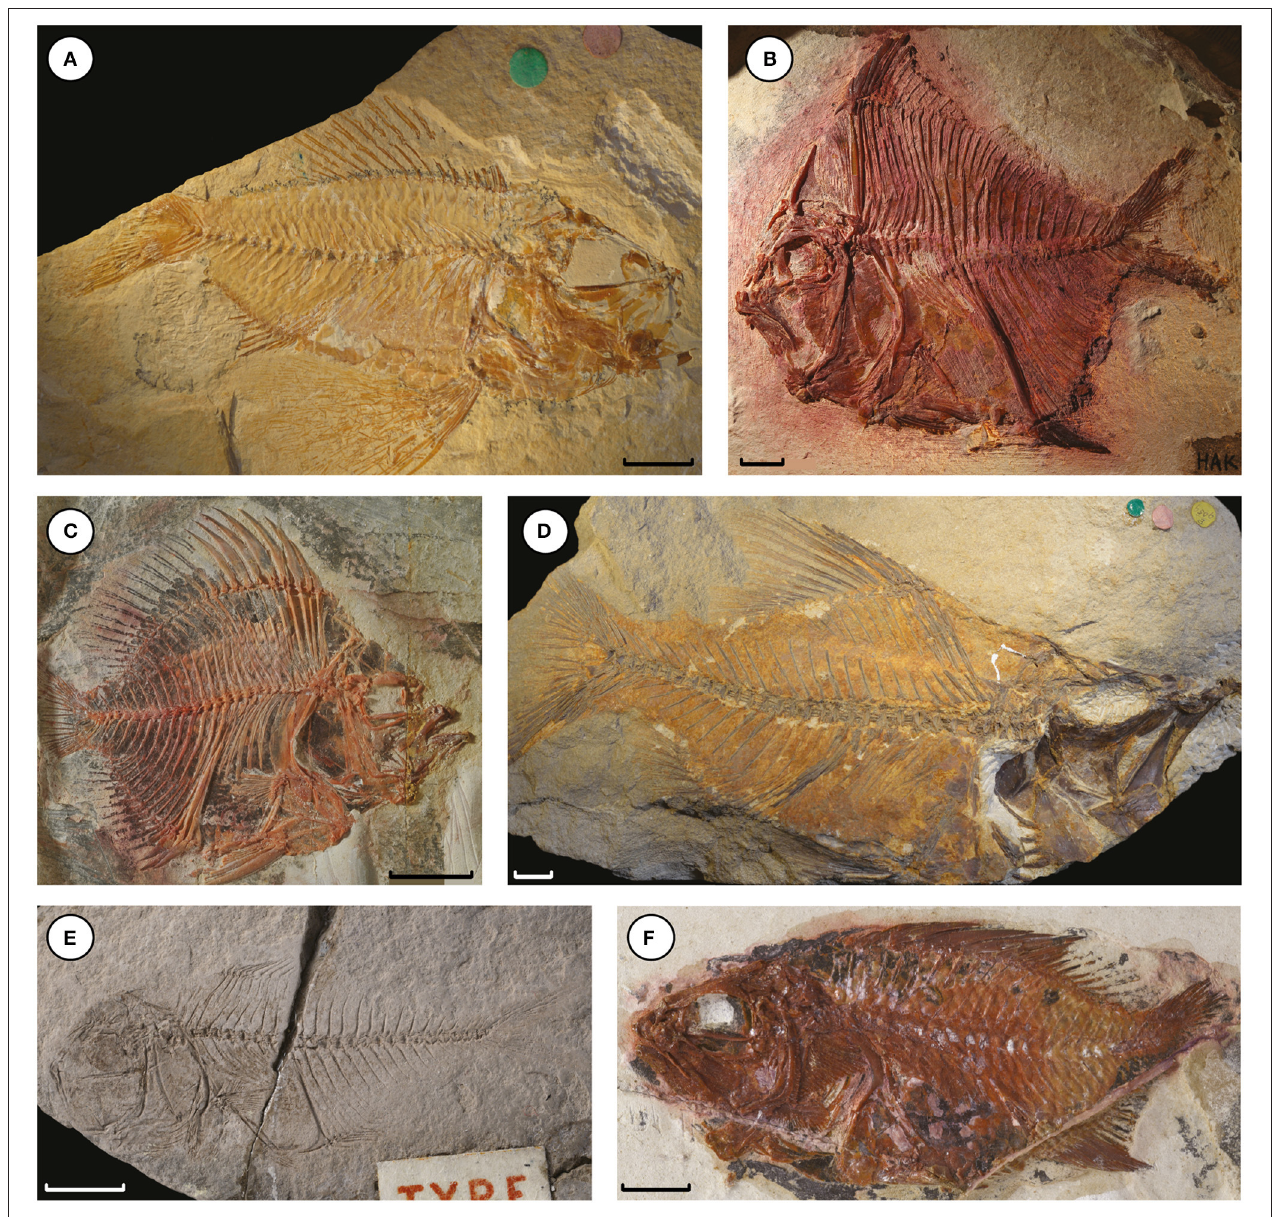
FIGURE 3 | Six of the seven fossil taxa used in the analyses. (A) † Ctenothrissa signifer , NHMUK PV P47524. (B) † ’ Aipichthys ’ velifer , MNHN.F.HAK57. (C) † Pycnosteroides levispinosus , MNHN.F.HDJ105. (D) † Sphenocephalus fissicaudus , NHMUK PV P9059. (E) † Omosomopsis simum , MNHN.F.DTS222d. (F) † Stichocentrus liratus , MNHN.F.HDJ97. Scale bar equals 10 mm (A–D , F) , 5 mm (E) . Photos by D. Davesne, C. Lemzaouda, and P.